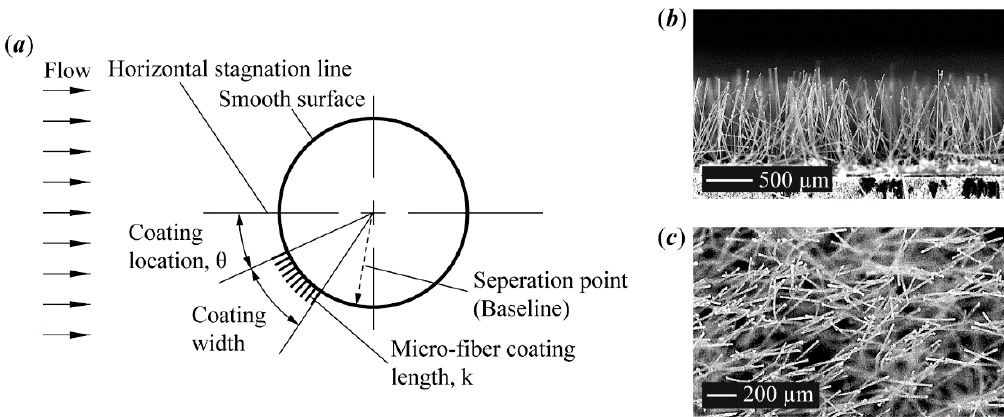
Figure 1. A schematic of a microfiber coating over the cylinder model: ( a ) Coating configuration on the cylinder model; ( b ) a microscope image of fabricated microfiber coating, side view ( k = 0.91 mm); ( c ) a microscope image of fabricated microfiber coating, top view ( k = 0.91 mm). Table 1. Microfiber coating parameters.